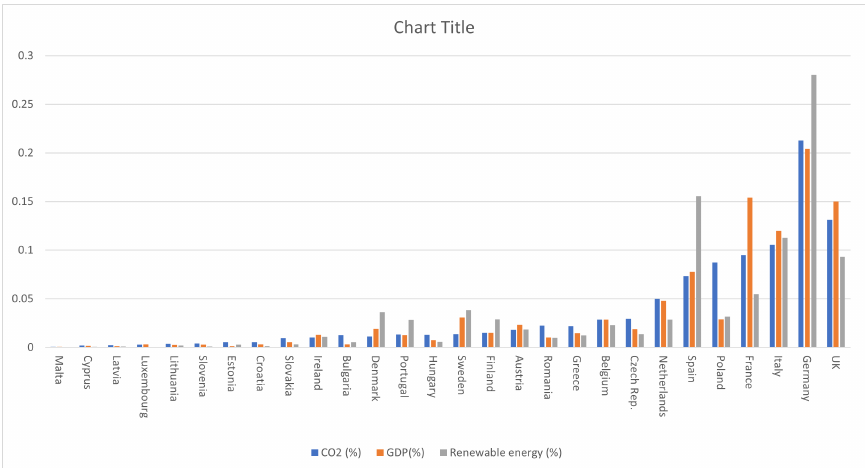
Figure 1. Percentage distribution of total EU CO 2 emissions, GPD and renewable energy production of each EU country over the interval time of five years from 2010 to 2014 (all data were collected from the World Bank Open Data project in 2020, see https://data.worldbank.org/indicator/EN.ATM.CO2 E.KT?view=chart (accessed on 6 September